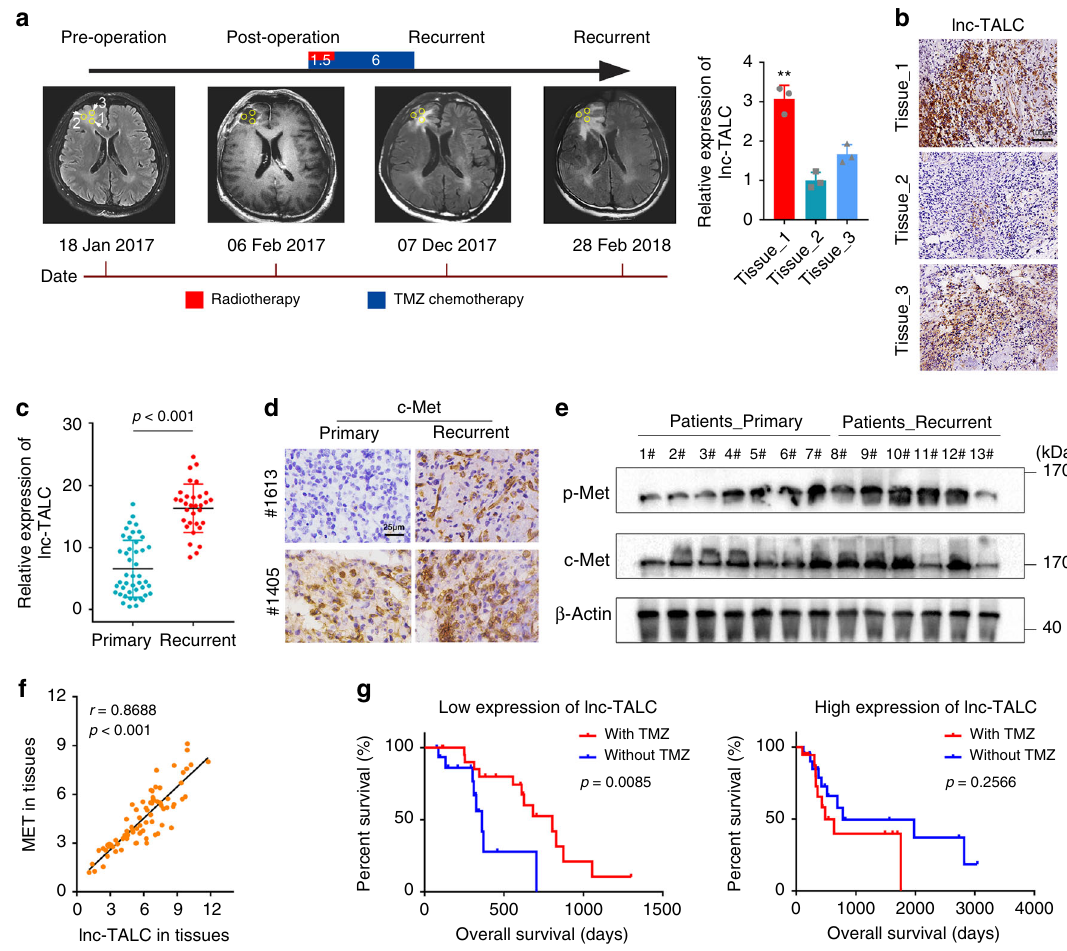
Fig. 8 Lnc-TALC is responsible for TMZ resistance and the recurrence of GBMs in clinical patients. a Left: Representative MR images show the timeline of treatment histories (top intervals labeled in months) for patients with GBM and the schematic process of multiple sampling (labeled 1, 2, and 3). Right: qRT-PCR of lnc-TALC in multiple samples (labeled 1, 2, and 3) from the same primary GBM. b ISH of lnc-TALC in multiple samples (labeled 1, 2, and 3) from the same primary GBM. Scale bar = 100 μ m. c qRT-PCR of lnc-TALC in primary and recurrent GBM tissues. The lnc-TALC expression was normalized to β -actin. d IHC of c-Met in tumor sections from primary and paired recurrent GBM samples. Scale bar = 25 μ m. e Western blot analysis of c-Met and p- Met in primary and recurrent GBM sample tissues. f Pearson correlation analysis between the lnc-TALC and MET levels in 77 GBM sample tissues. g Kaplan-Meier curves of OS in GBM patients with or without TMZ chemotherapy. Left: Patients with low lnc-TALC expression. Right: Patients with high lnc-TALC expression. Data are presented as the mean ± S.D. P value was determined by Student ’ s t -test, one-way ANOVA, Pearson ’ s correlation test or Log-rank test. Signi fi cant results were presented as NS non-signi fi cant, * P < 0.05, ** P < 0.01, or *** P <